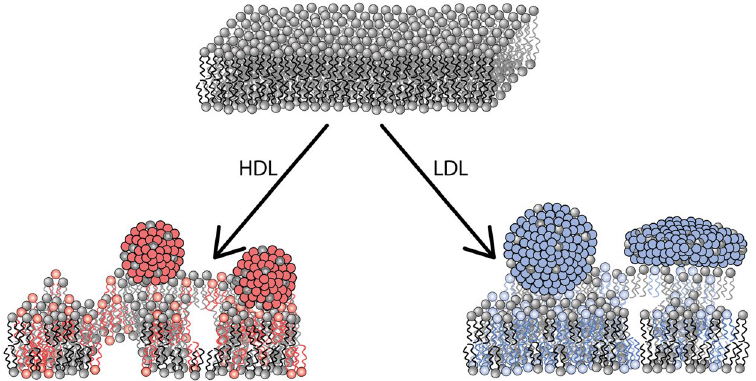
Figure 5. Schematic illustration showing lipoprotein-mediated uptake and exchange of lipids between supported lipid bilayers and lipoprotein particles. Drawing not to scale. For clarity rearrangement after lipid removal around pores in the membrane has not been depicted, further discussion can be found in the